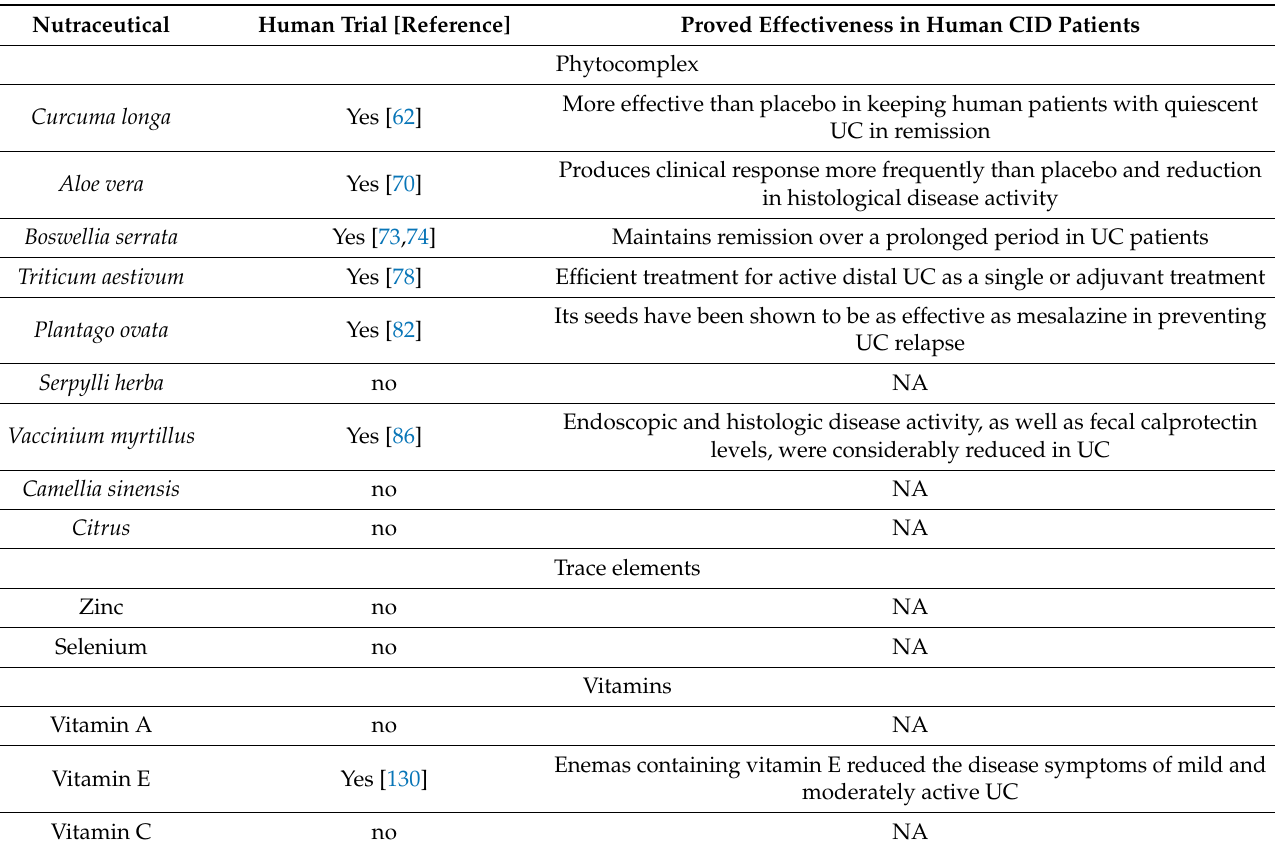
Table 1. Main human trials testing the antioxidant effects of nutraceuticals in CID